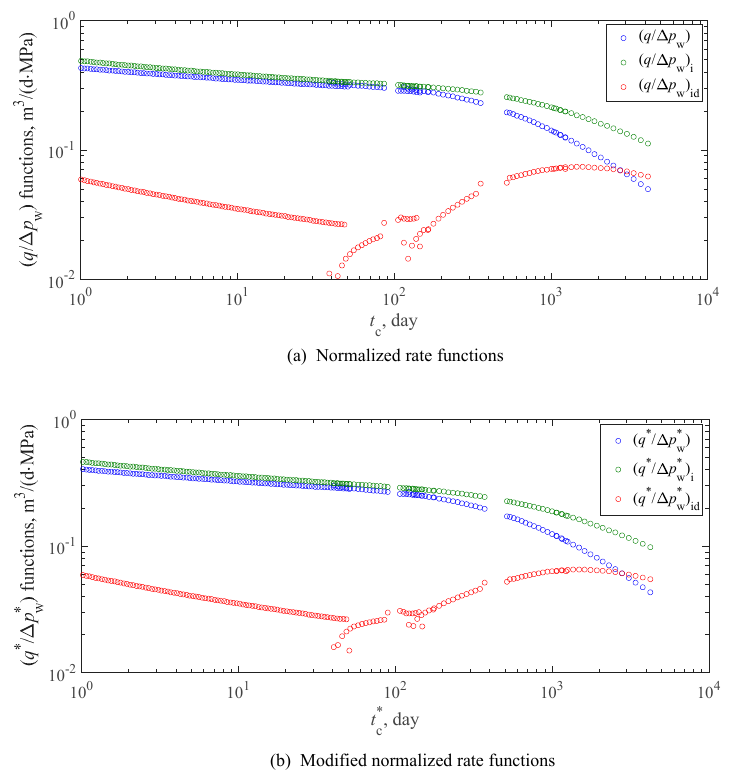
Figure 23. Normalized rate functions and modified normalized rate functions for Case 4.